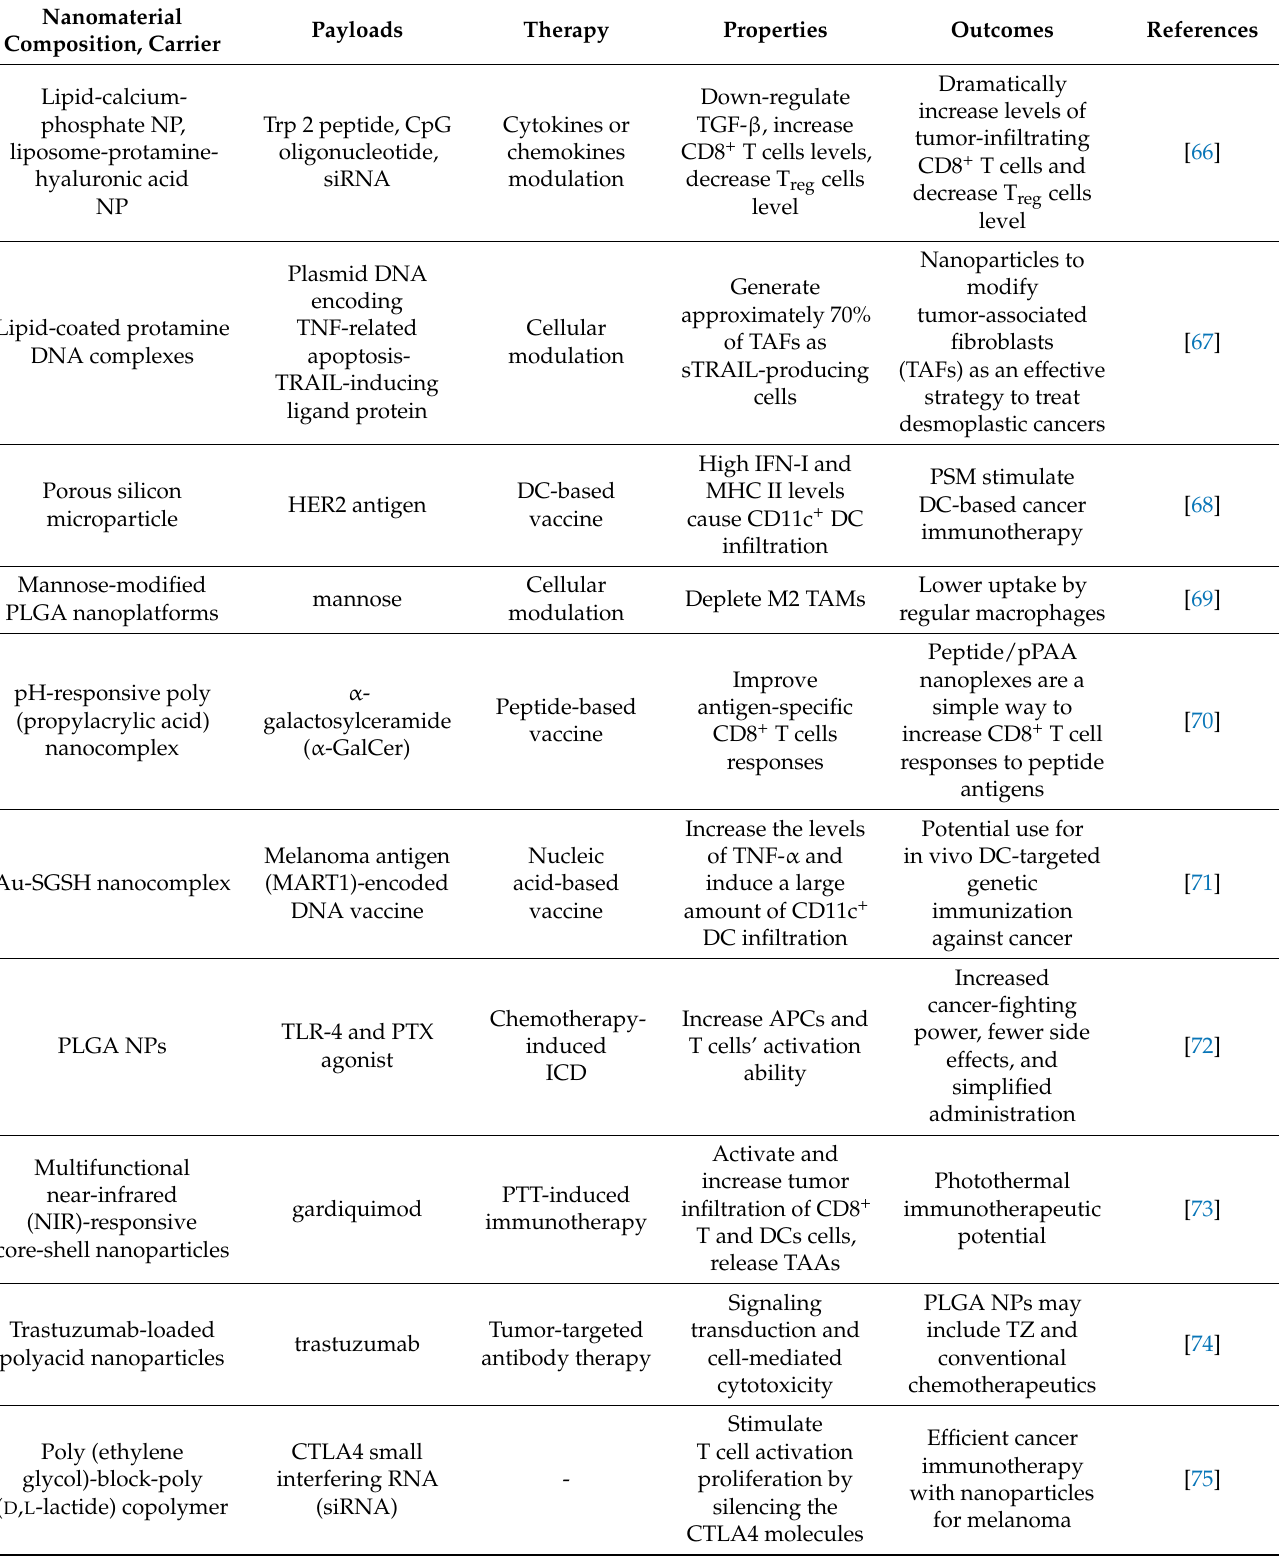
Table 1. Different immunotherapies are based on